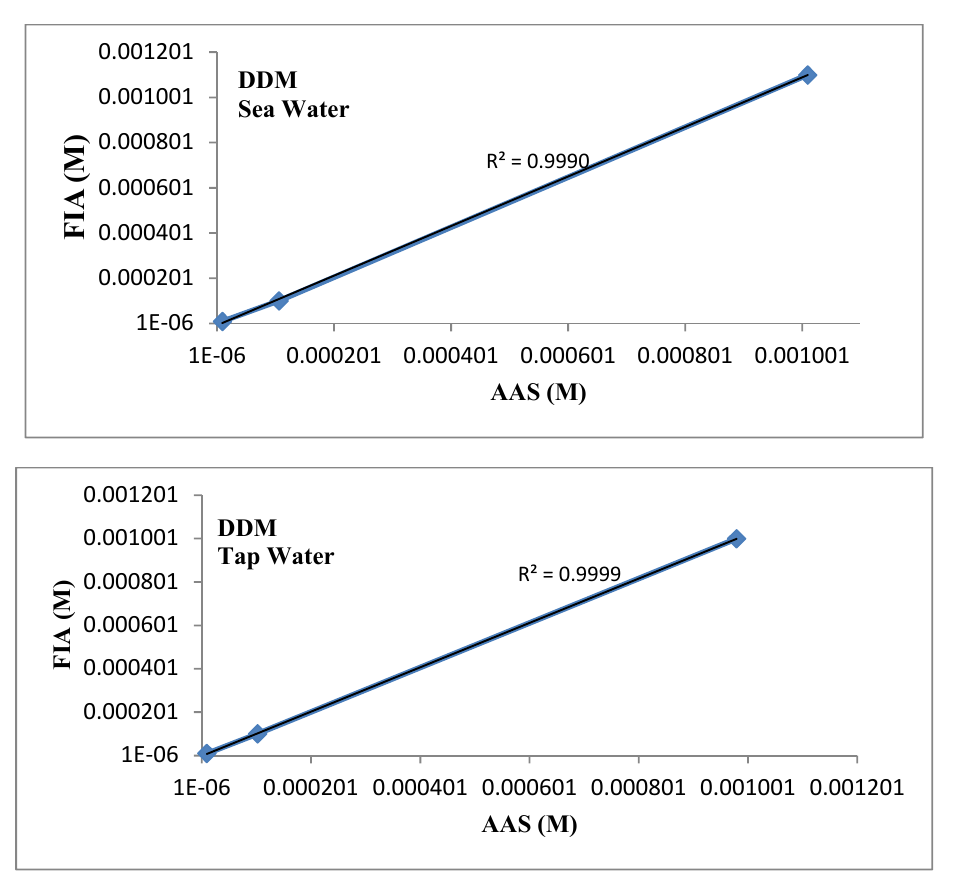
Figure 7. Validation of the proposed mercury(II)-ISE in FIA system by AAS